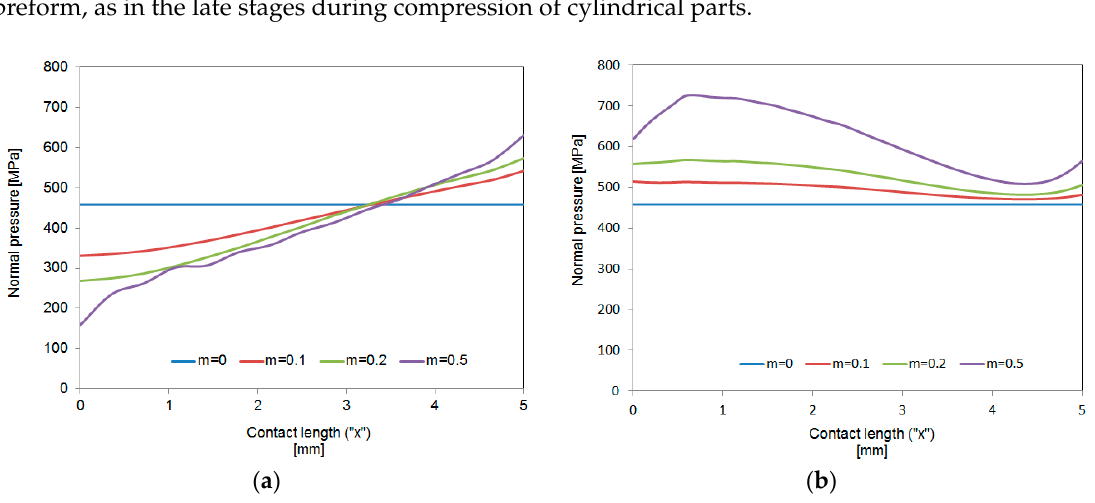
Figure 13. Contact pressure profiles for different friction conditions. ( a ) Slim preform ( d = 10 mm and h = 20 mm); ( b ) Flattened-shape preform ( d = 10 mm and h = 3 mm).